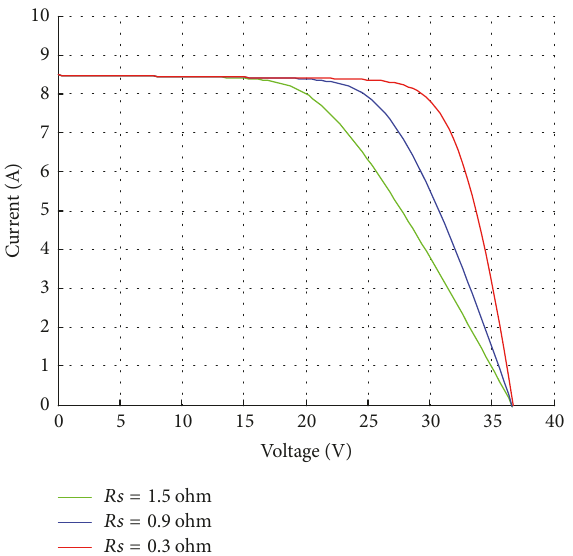
Figure 11: 𝐼 - 𝑉 curves for different 𝑅 s .